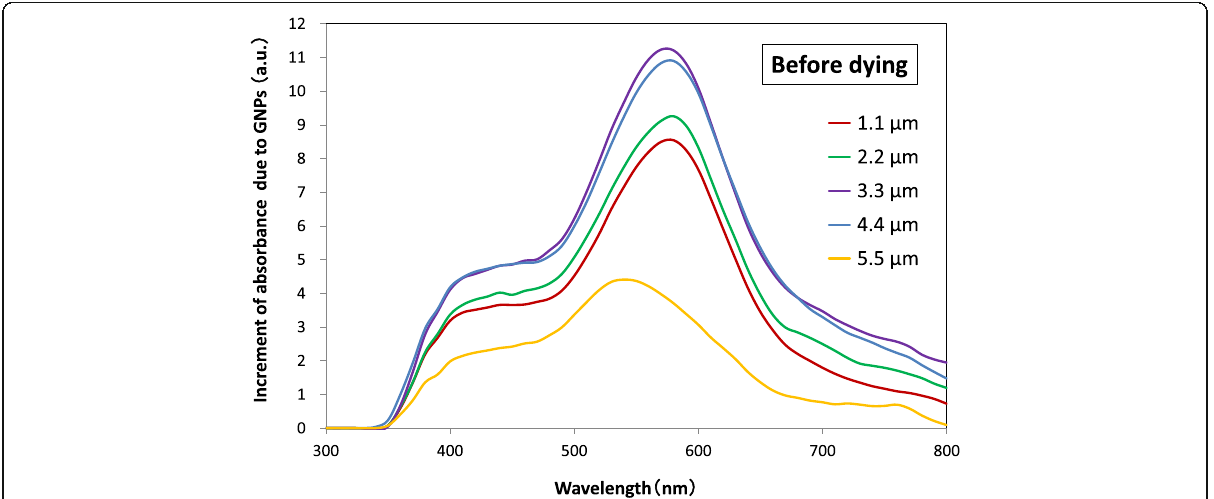
Fig. 6 Increment of absorbance due to GNPs with varying the position of a GNP layer in the TiO 2 layer. The density of GNPs is 2.7 μ g/cm